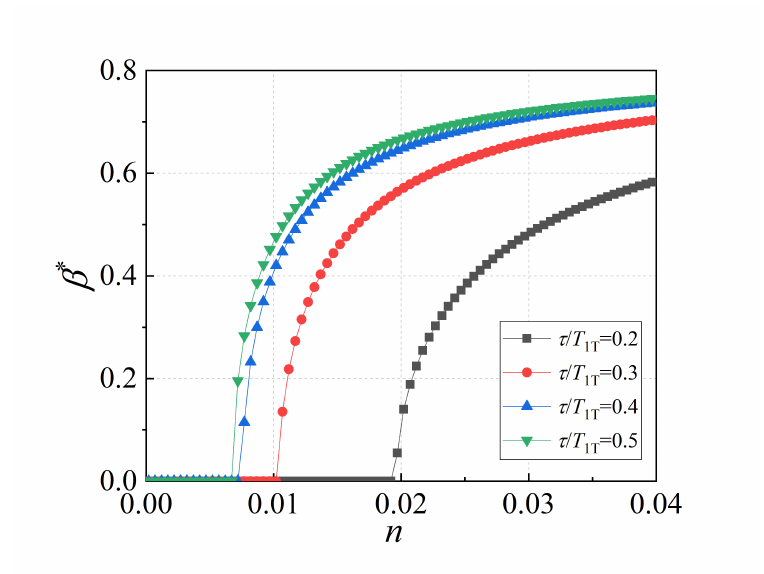
Figure 9. Bifurcation diagrams of the first transverse mode of the BKD combustor for different time delay τ of the